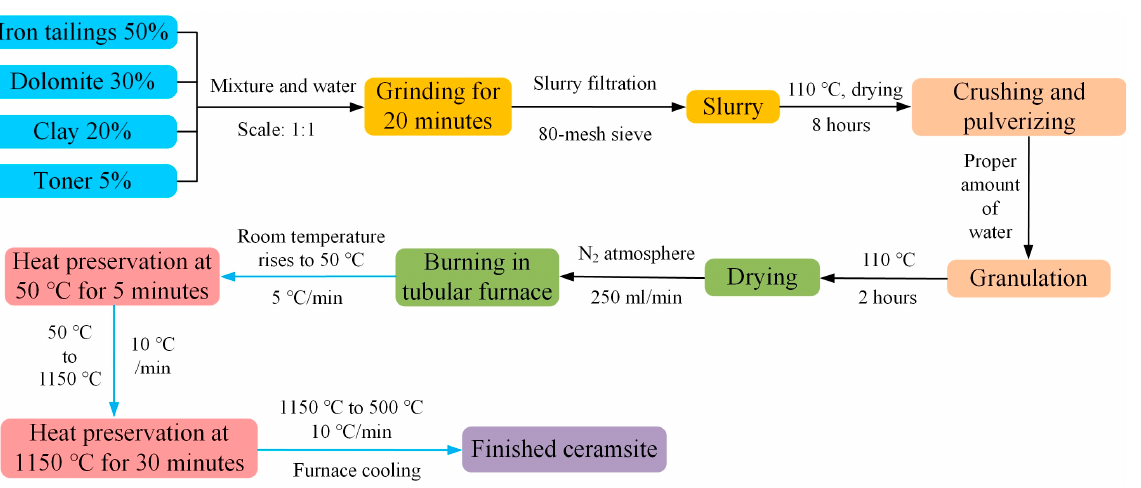
Figure 9. Preparation process of ceramsite.